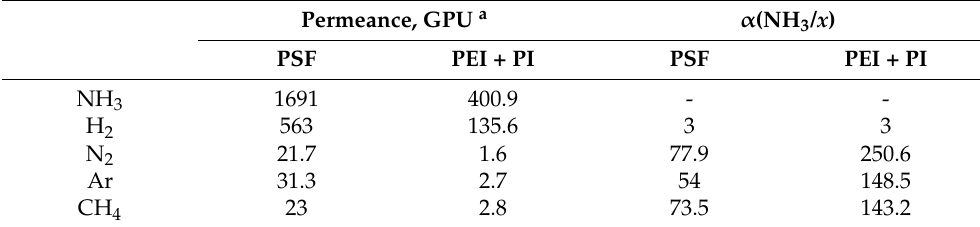
Table 4. PSF and PEI+PI hollow fiber membrane permeance for pure gases. Permeance, GPU